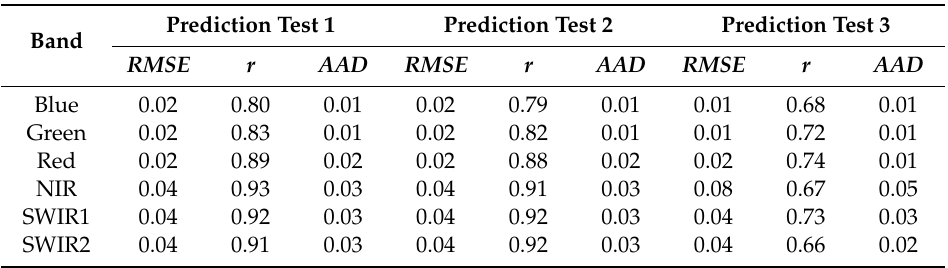
Table 2. Root Mean Square Error ( RMSE ), Correlation Coe ffi cient ( r ), and Absolute Average Di ff erence ( AAD ) between the STARFM-predicted surface reflectance and the corresponding Landsat surface reflectance.